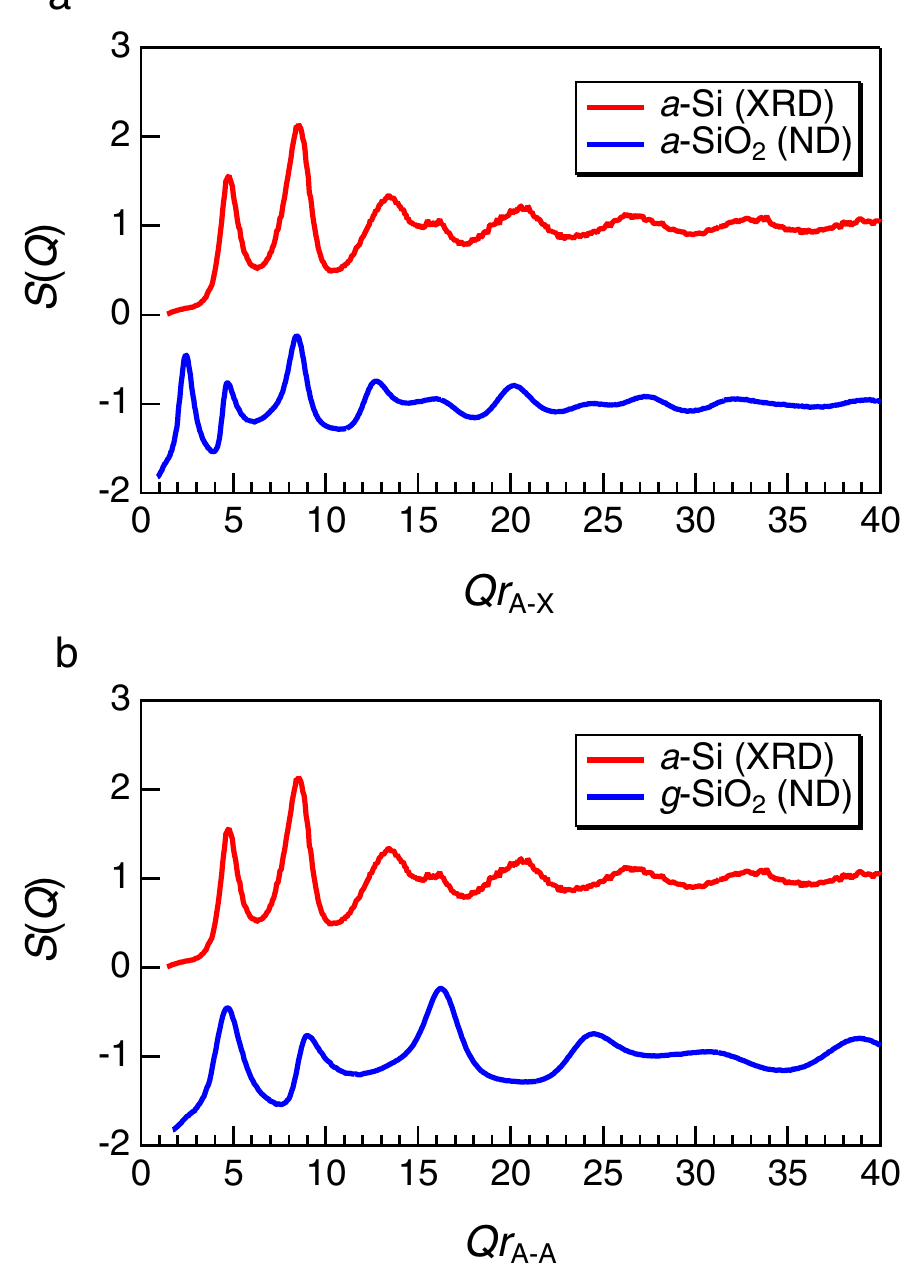
Figure 3. Structure factors S ( Q ) for a -Si and a -SiO 2 scaled by a r A-X ( a ) and ( b ) r A-A29 . r A-X for a -SiO 2 is 1.61 Å, and r A-A for a -SiO 2 and a -Si are 3.10 Å and 2.35 Å,